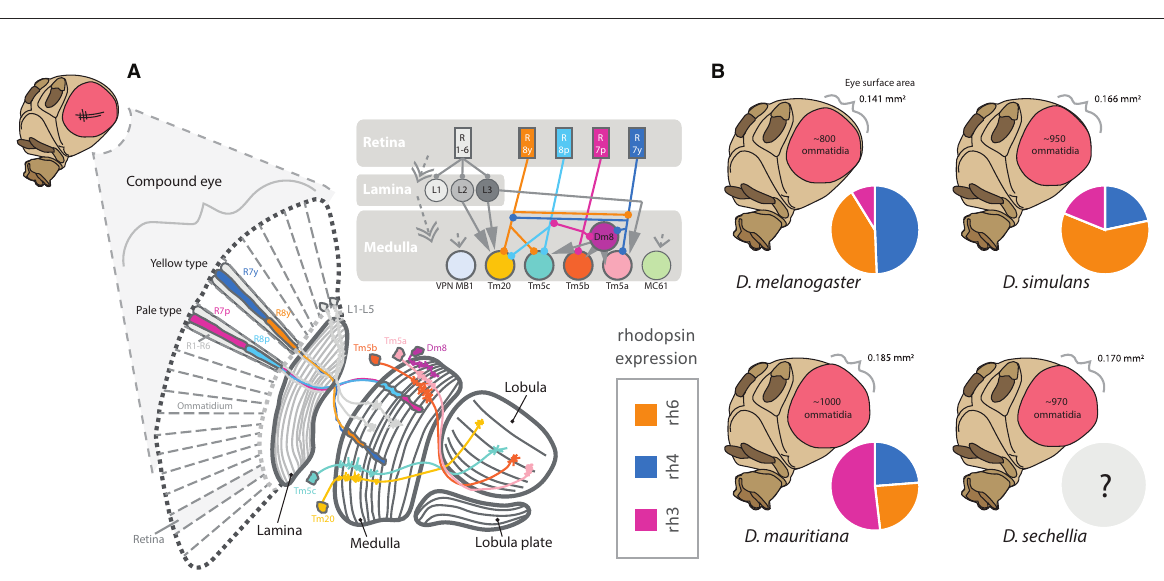
FIGURE7 An overview of visual processing in the fly brain. (A) The compound eye contains hundreds of ommatidia, including two primary types, yellow and pale. Each ommatidium projects into the retina of the compound eye. These ommatidia contain distinct rhabdomeres expressing combinations of rhodopsins (rh1-rh7). Photoreceptors associated with rhabdomere/rhodopsin combinations detect light, wavelength, color, and visual movement, where these stimulation and information from the compound eye are then passed into the optic lobe. The optic lobe contains 4 major components, including the lamina, medulla, lobula, and lobula plates. (B) The number of ommatidia varies significantly between even close relatives. In addition, the ratio or allocation of ommatidia containing different rhodopsins (e.g., rh3) for color vision is also quite variable. Thus, while overall eye size differs between the species, the increase in visual sensory inputs does not appear to be